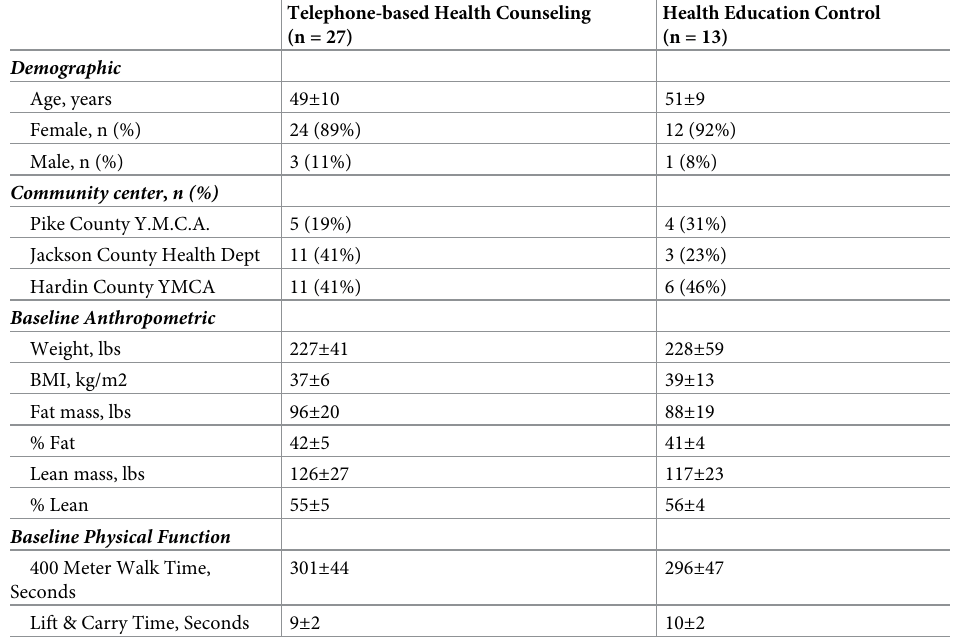
Table 2. Baseline characteristics of participants by study